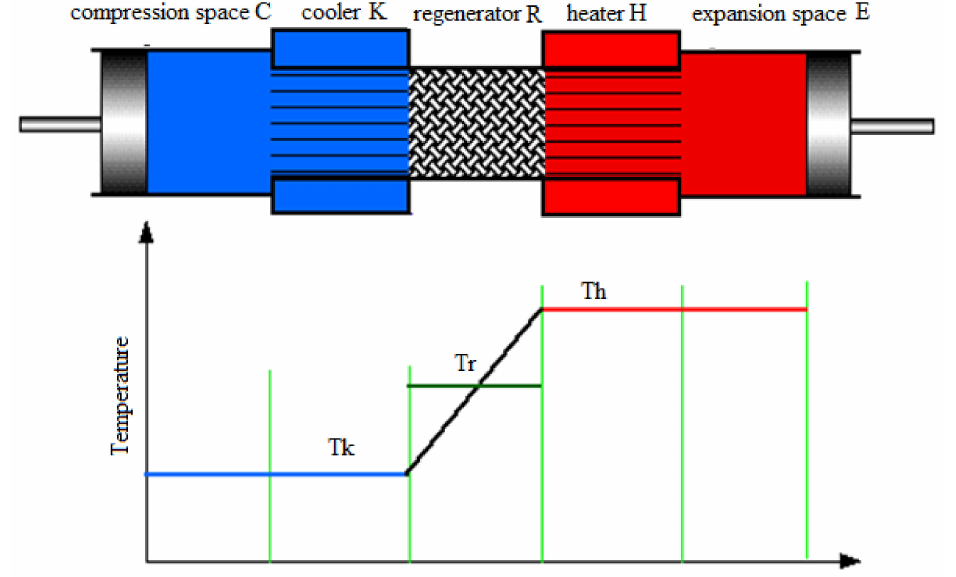
Figure 4. Isothermal model and temperature